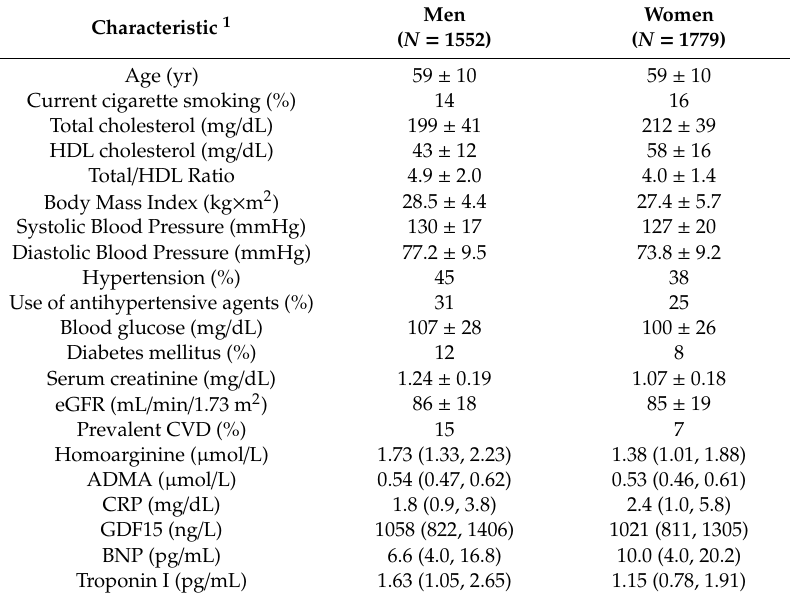
Table 1. Baseline characteristics of study